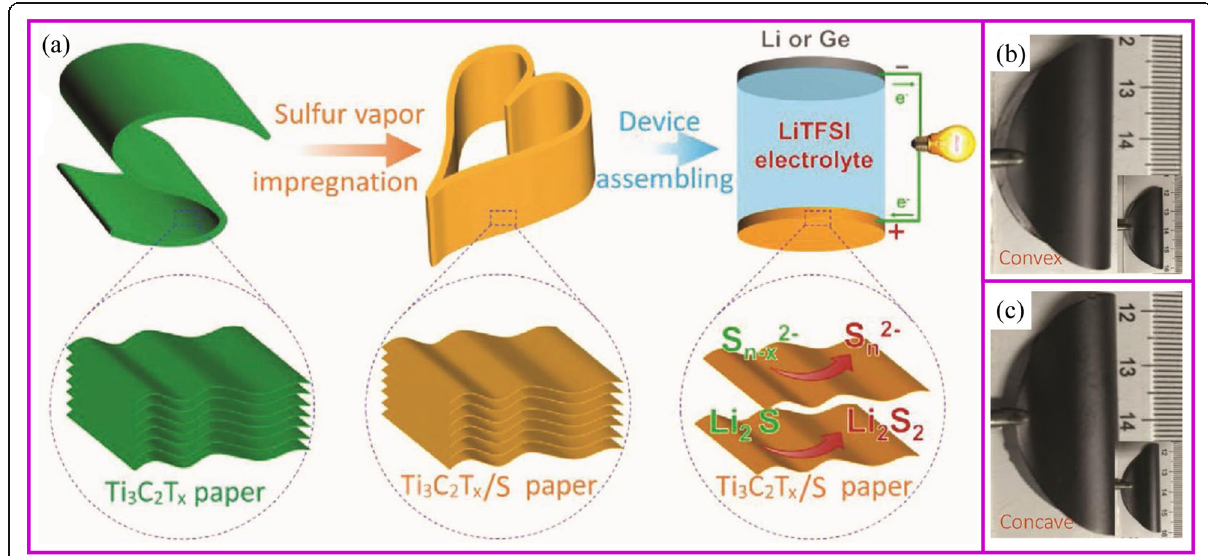
Fig. 9 a The scheme of fabrication of robust, freestanding, and conductive Ti 3 C 2 T x /S paper. Photographs of freestanding Ti 3 C 2 T x /S paper when bending b convexly and c concavely, showing good mechanical flexibility similar to that of the pure Ti 3 C 2 T x paper